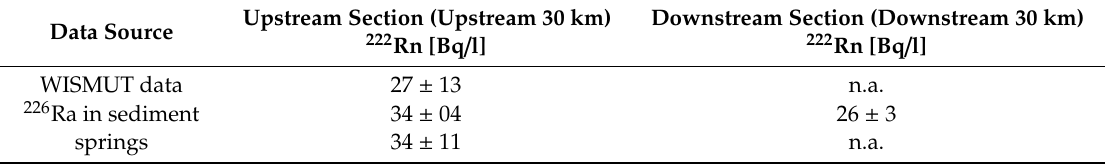
Table 1. Groundwater radon activities from various